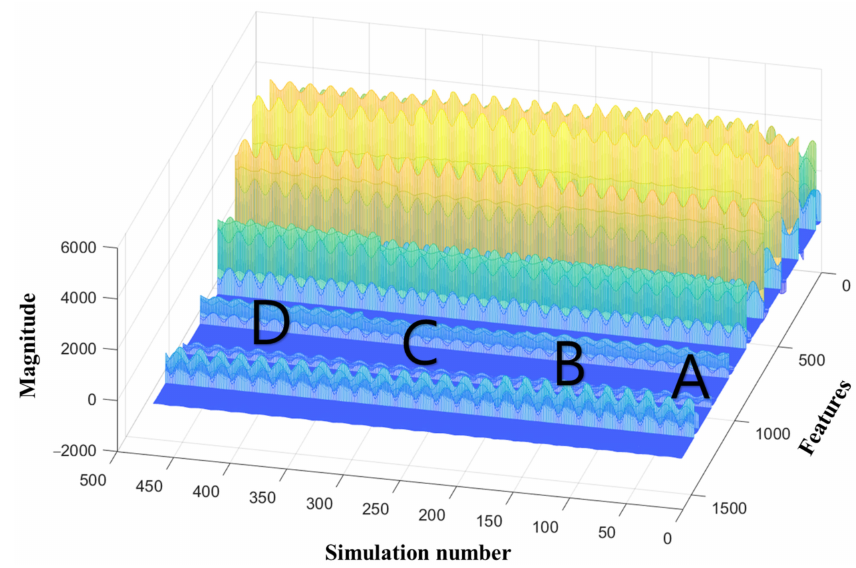
Figure 11. Input data-flattened frequency components by fault type.